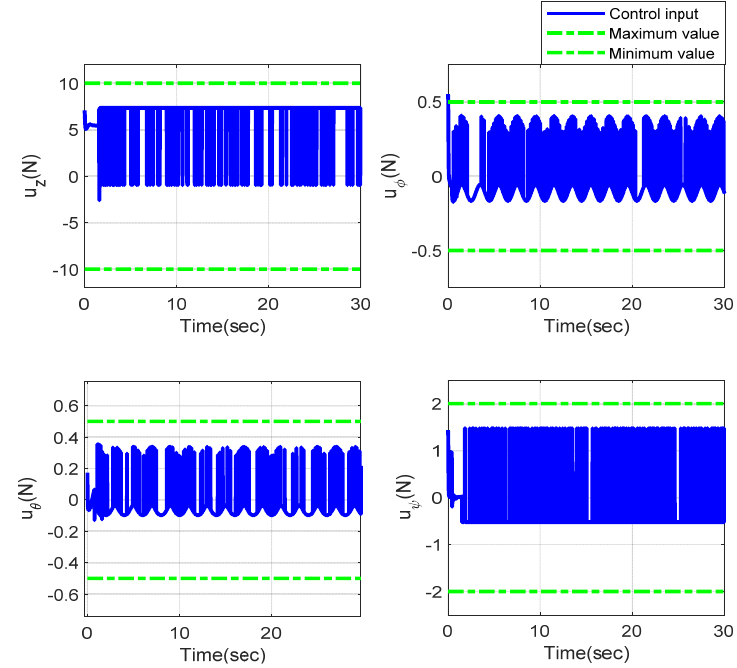
Mathematics 2022 , 10 , x FOR PEER REVIEW Figure 7. Trajectories of the control inputs. Figure 7. Trajectories of the control inputs.